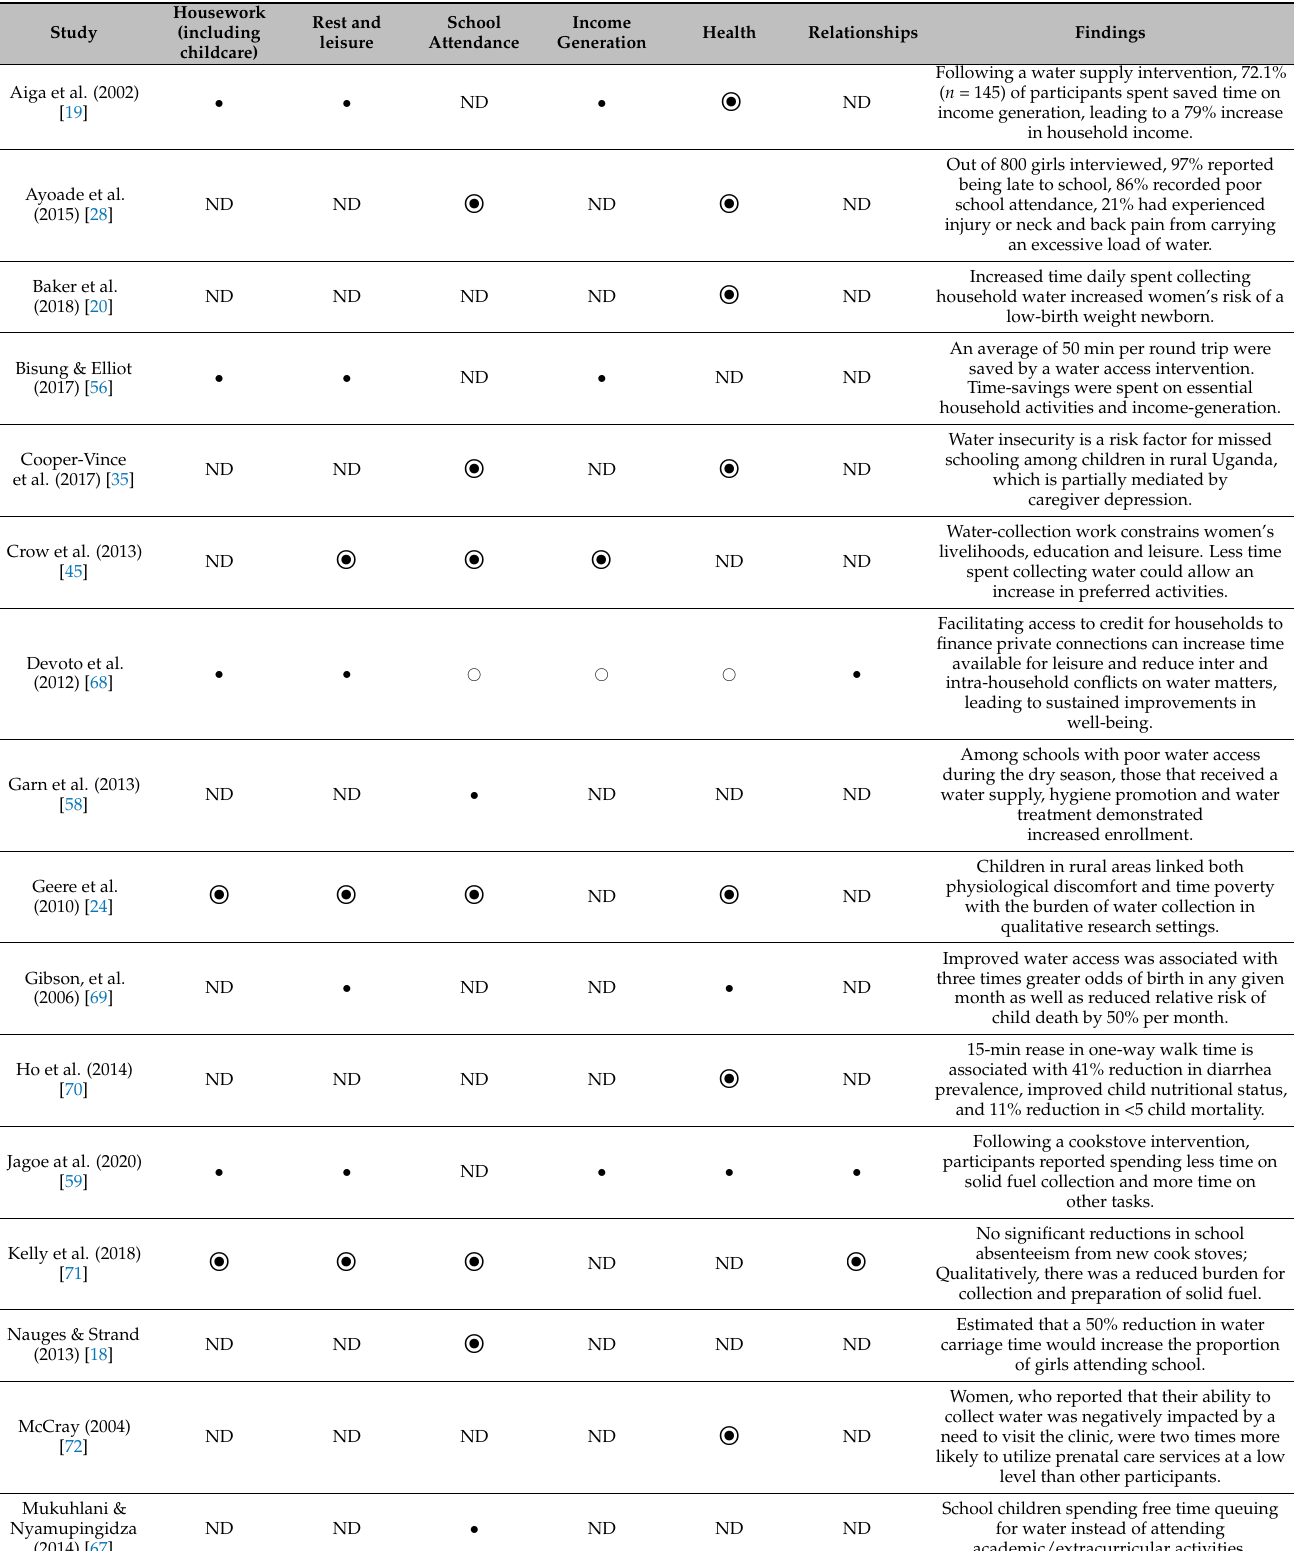
Table A4. Demonstrated or estimated effects associated with reducing the time burden associated with water and solid fuel collection and transport.